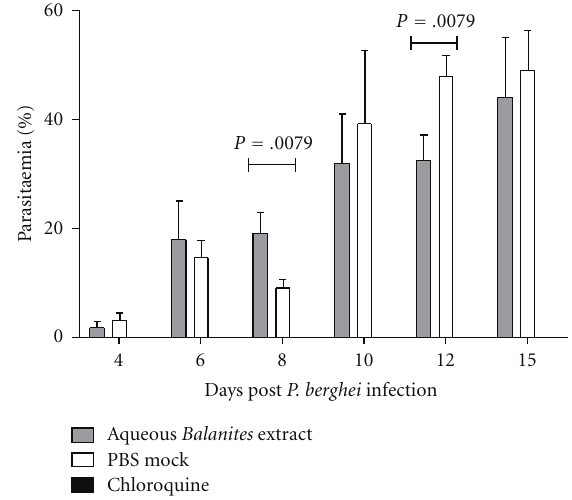
Figure 6: Parasitemia of Plasmodium berghei -infected ANKA strain-infected BALB/c mice after treatment with 50 µ L of the aqueous Balanite extract (1,25 g/100mL) in comparison to the PBS- bu ff er-treated control. Administration was performed intraperi- toneally on days 3, 2, and 1 before infection, at the day of infection and on days 1, 2, 3, 4, 5, 6, 7, and 8 after infection. Giemsa-stained smears were performed on days 4, 6, 8, 10, 12, and